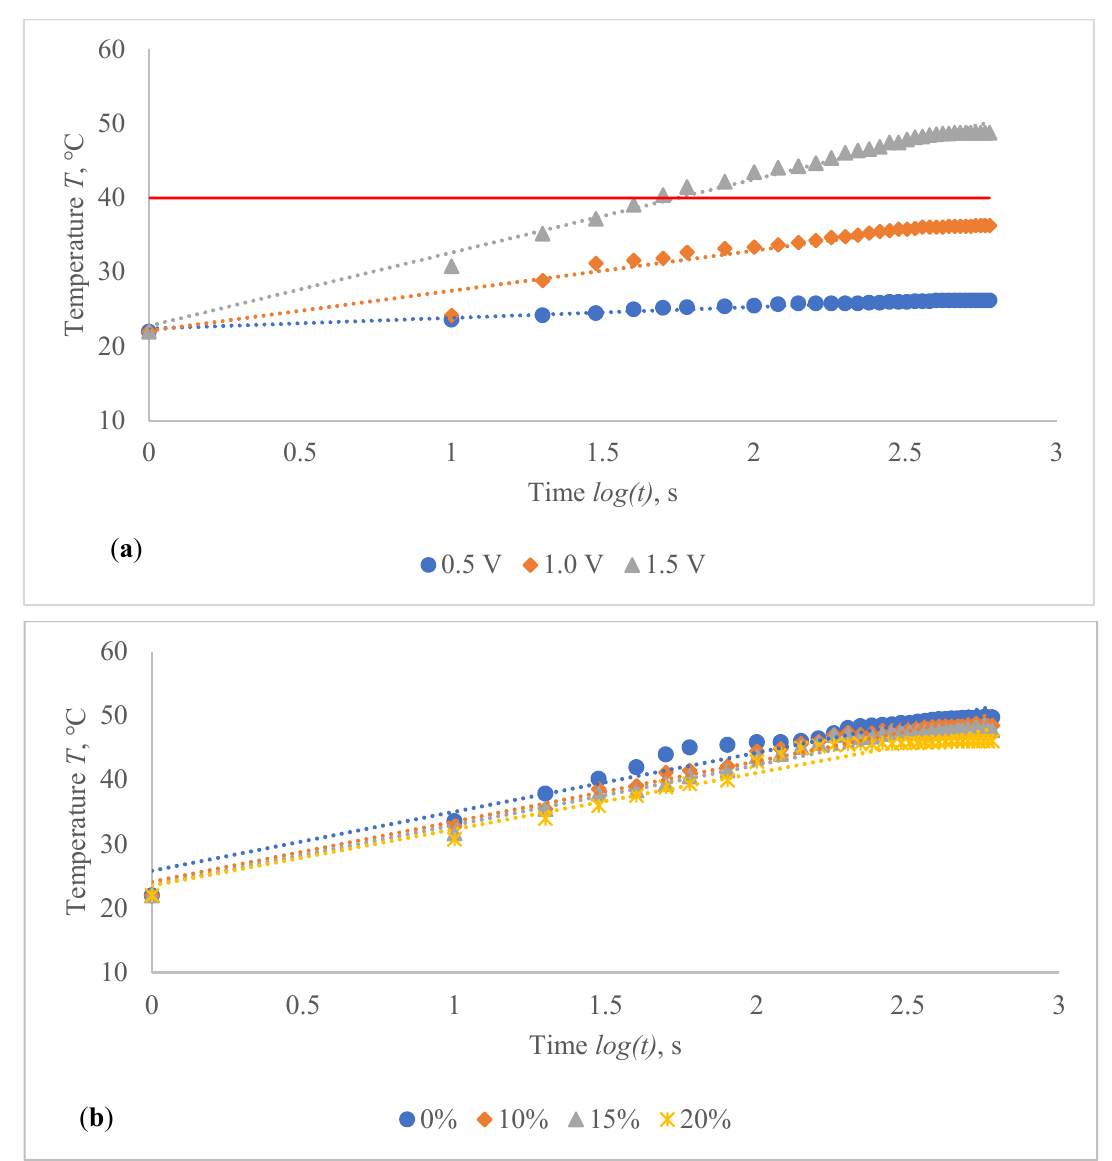
Figure 13. Temperature changes of CF_HY1 structured electro-conductive composite fabric during the 600 s period: ( a ) at non-stretched state by applying different voltage; and ( b ) at the different stretch levels by applying 1.5 V. Red line indicates the target